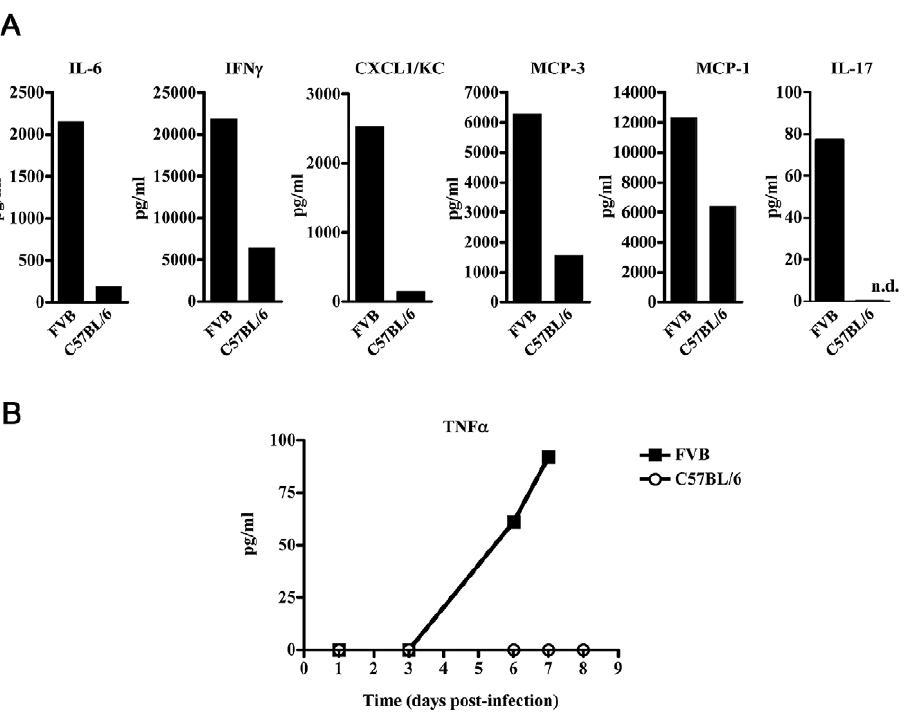
Figure 6. FVB mice infected with LCMV produce increased systemic cytokine and chemokine profiles. FVB or C57BL/6 mice were infected with 1–2 6 10 6 p.f.u. LCMV-13 and serum harvested from 4–5 mice was combined and assayed for cytokine and chemokine levels. A) Serum levels of IL-6, IFN- c , MCP-1, MCP-3 and CXCL1/KC measured 3 days post infection in FVB and C57BL/6 mice and IL-17 was measured day 1 post- infection. B) Serum levels of TNF- a were measured in FVB and C57BL/6 mice at indicated times post-infection. Results are representative of three independent experiments.